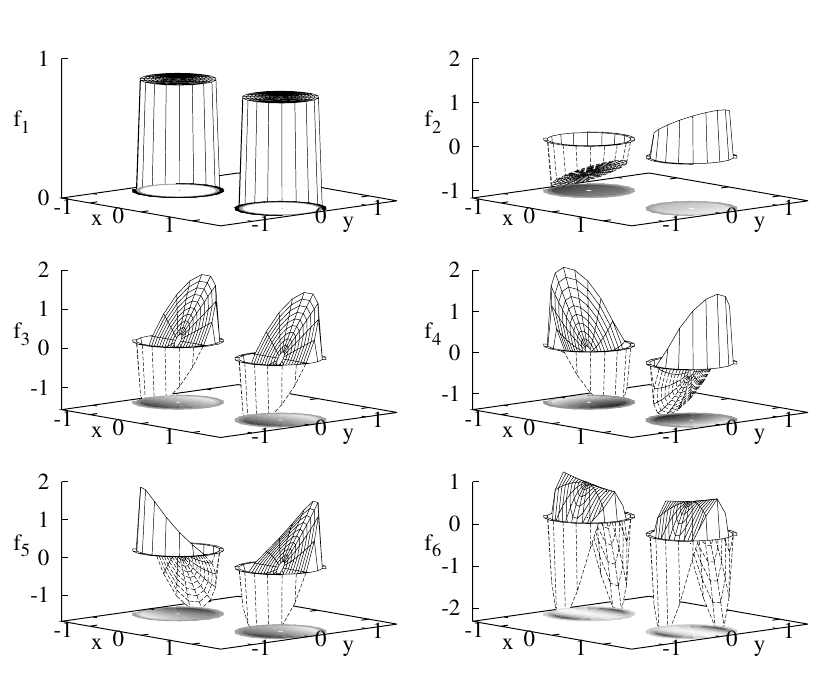
Fig. 2. The basis functions f 1 to f 6 for q = 1 =